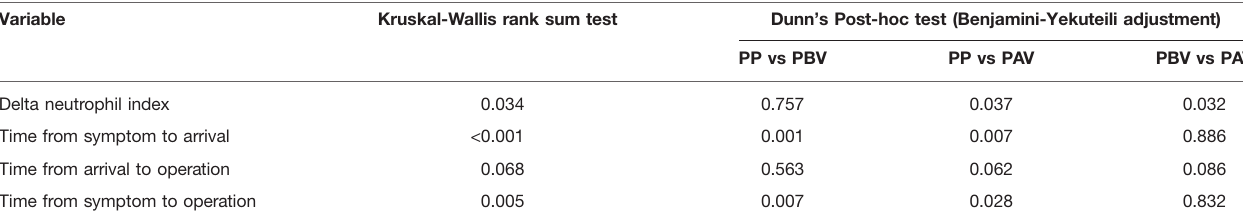
TABLE 2 | P values of Kruskal-Wallis rank sum test and Dunn ’ s Post-hoc test by Benjamini-Yekuteili adjustment. Variable